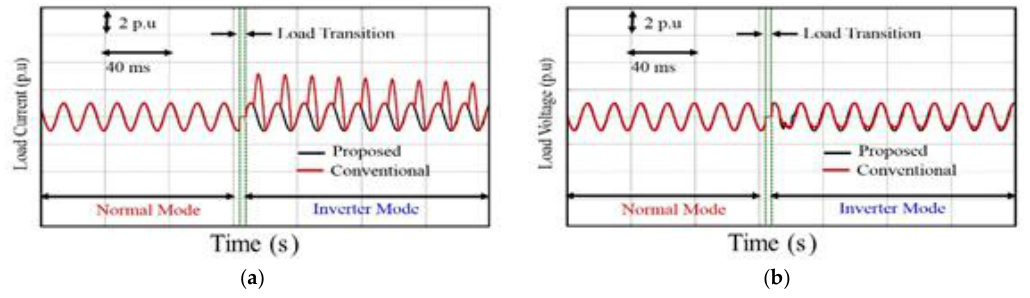
Figure 12. ( a ) Load current; and ( b ) load voltage for the conventional and proposed single-phase offline UPS topologies when the inverter voltage is injected at 0°.